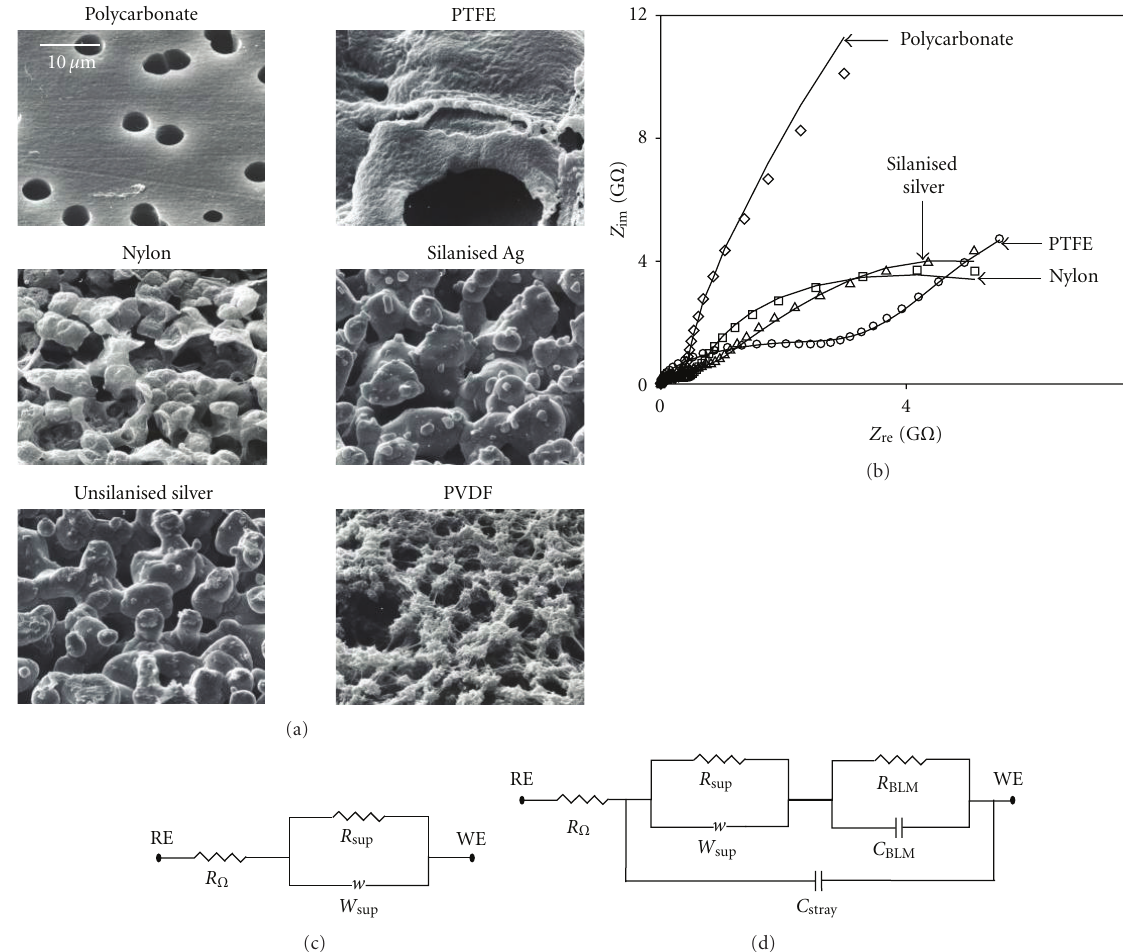
Figure 1: (a) Electron micrographs showing surfaces and structures of various porous materials (magnification × 2000). (b) Faradaic impedance spectra are presented in the form of Nyquist plots showing real (Z re ) versus imaginary (Z im ) components of BLMs formed on di ff erent porous support materials. Electrical circuit models for support (c) and supported BLM (d).